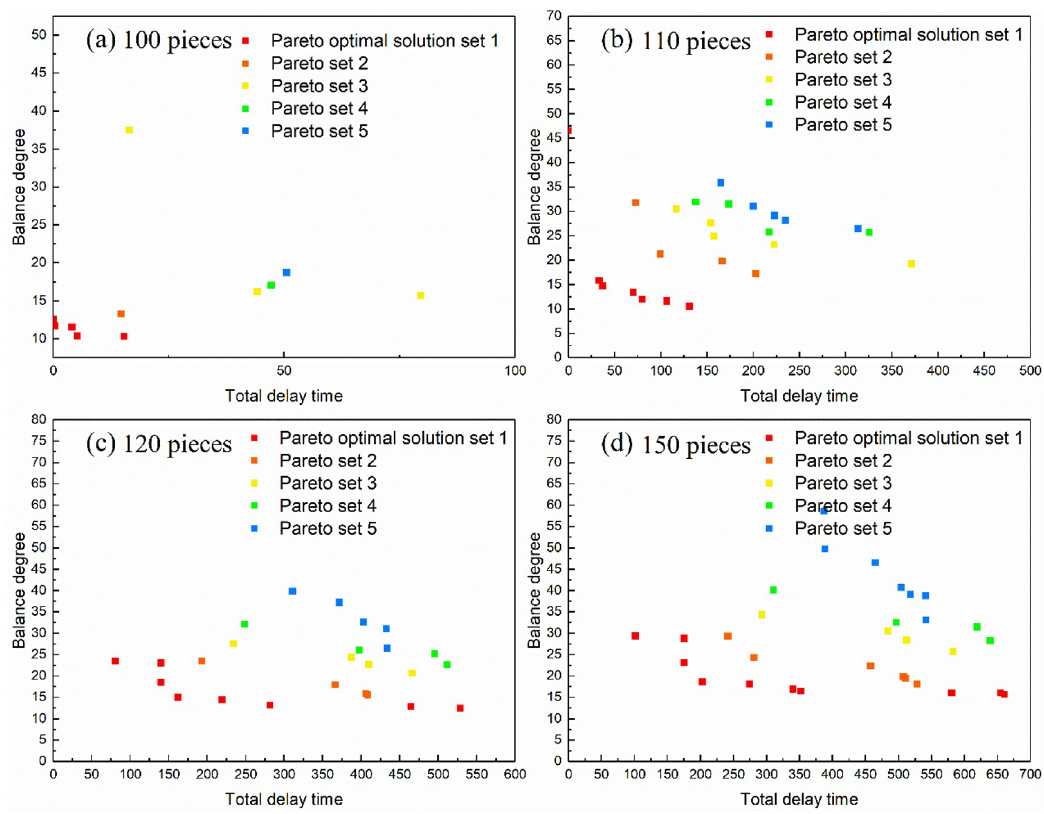
Fig 2. Pareto diagram after solving each imitation case.